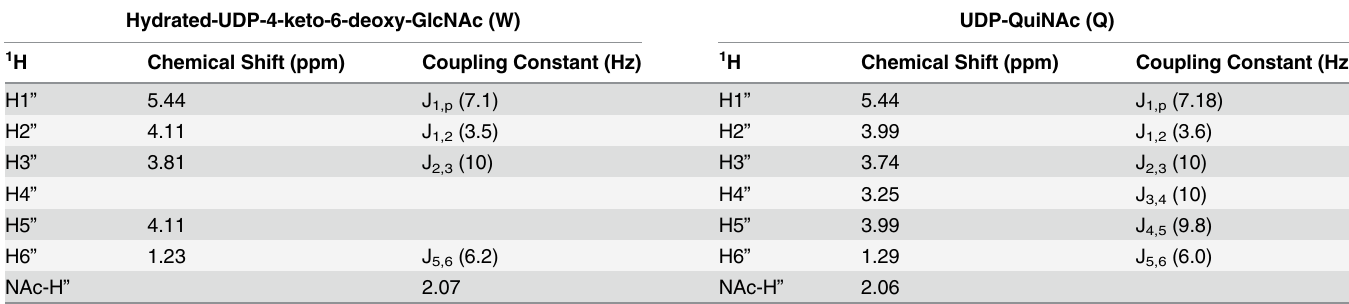
Table 2. NMR data for the sugar moiety of UDP-4-keto-6-deoxy-GlcNAc (W) and UDP-QuiNAc (Q). Hydrated-UDP-4-keto-6-deoxy-GlcNAc